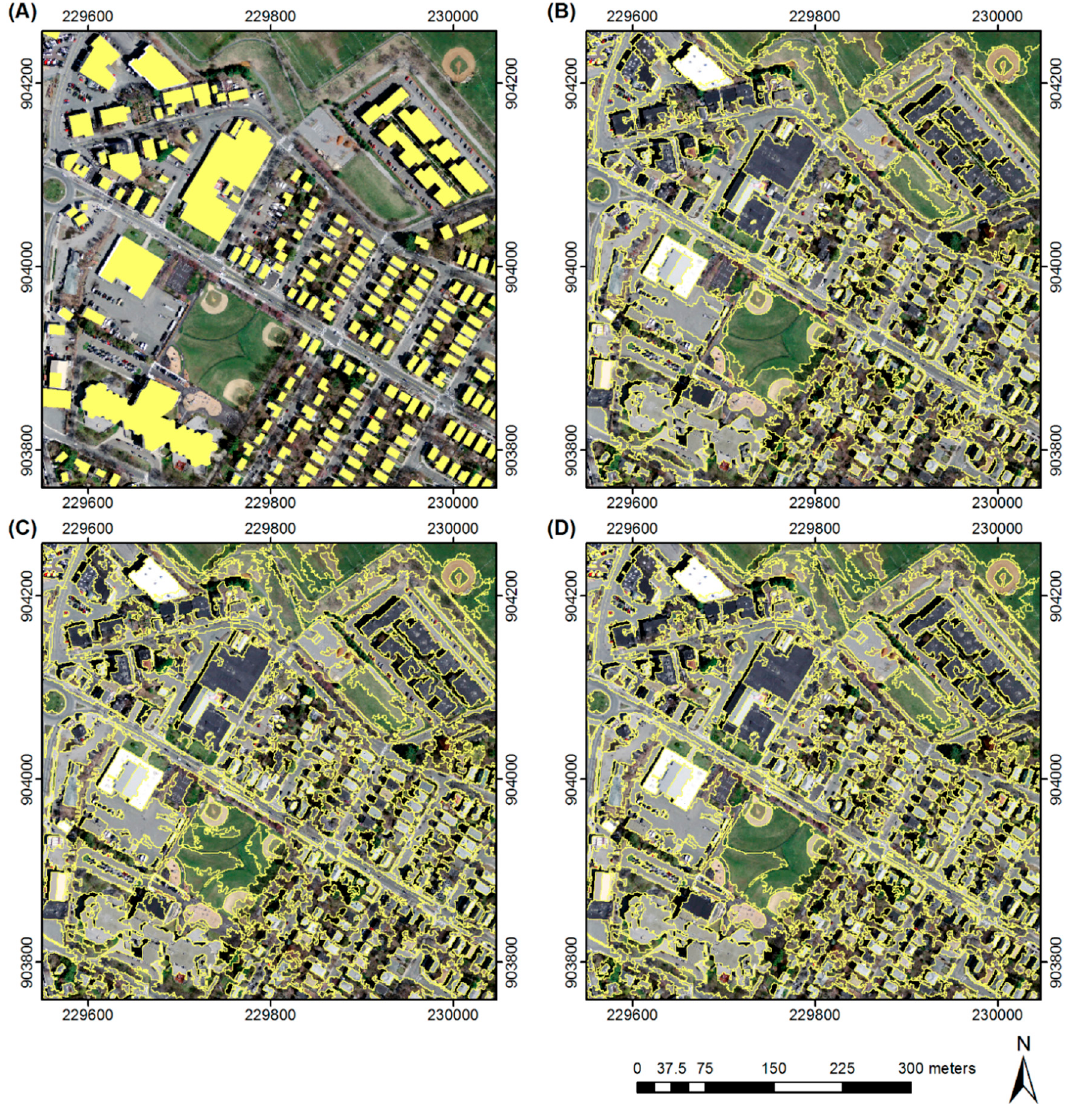
Figure 3. ( A ) The spectral data overlapped by the reference building dataset. The segmentation results for building delimitation from spectral data produced by three methods: ( B ) MRS ( SP global = 60), ( C ) region merging with global SP ( SP global = 50), and ( D ) region merging with local SPs ( SP global = 50)), using the optimum SP global indicated by the unsupervised evaluation.